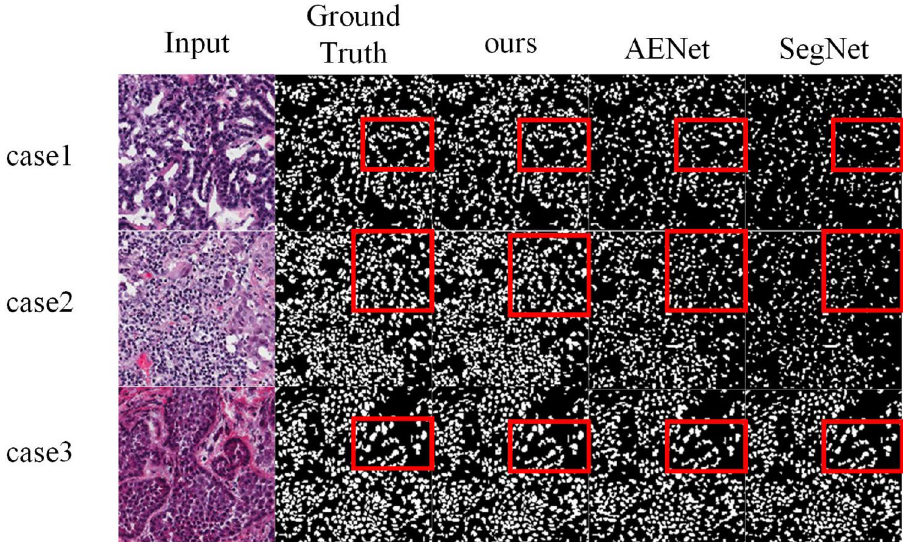
Figure 6. shows the qualitative results of TGMLP U-Net in MoNuSeg task versus results of other models. Our model shows better learning and generalization abilities, resulting in better performance.